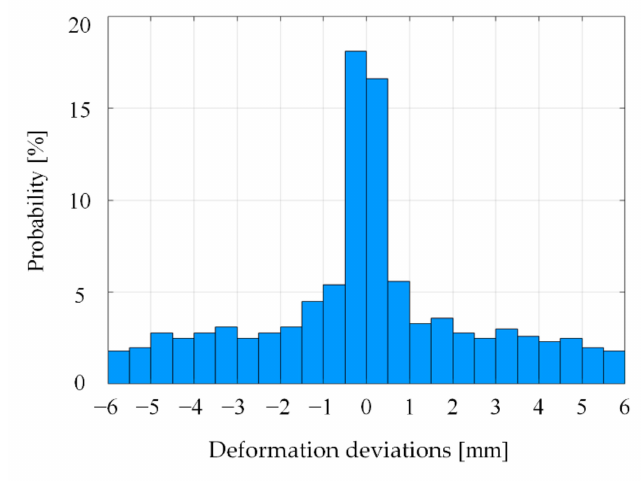
Figure 6. Probability distribution for deformation deviations.